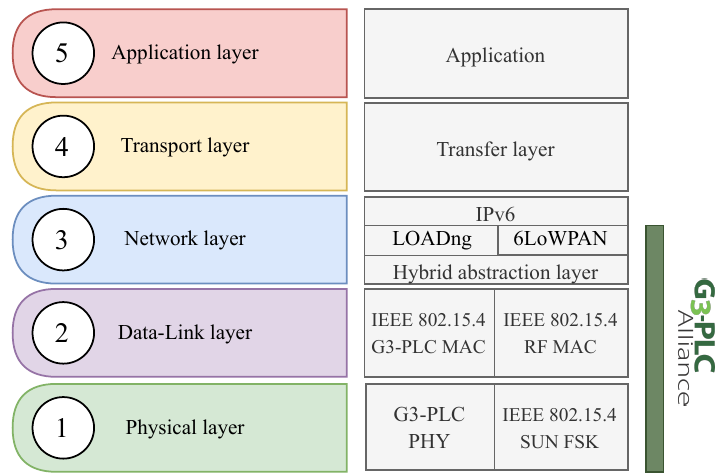
Figure 15. G3-PLC Hybrid PLC and RF protocol